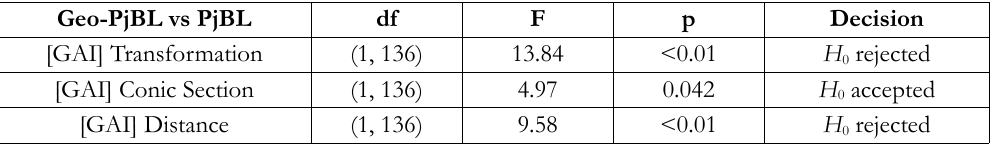
Table 3. Effectiveness of Geo-PjBL